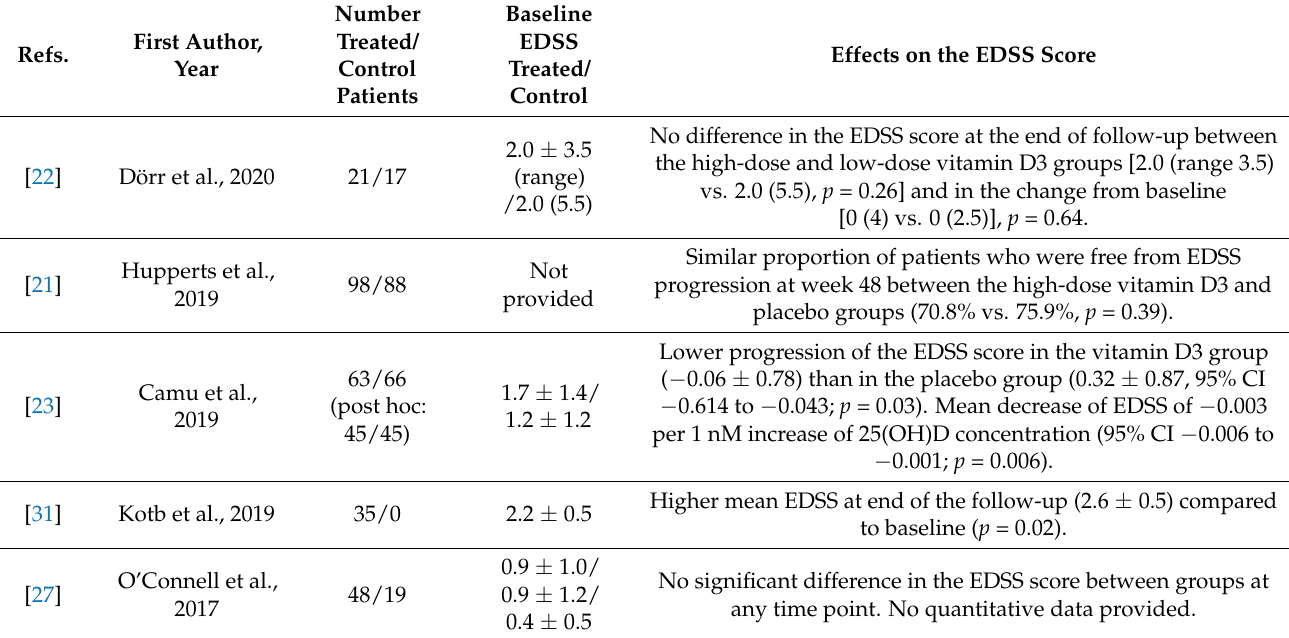
Table 6. Summary of observations on the EDSS score after vitamin D supplementation in MS patients.